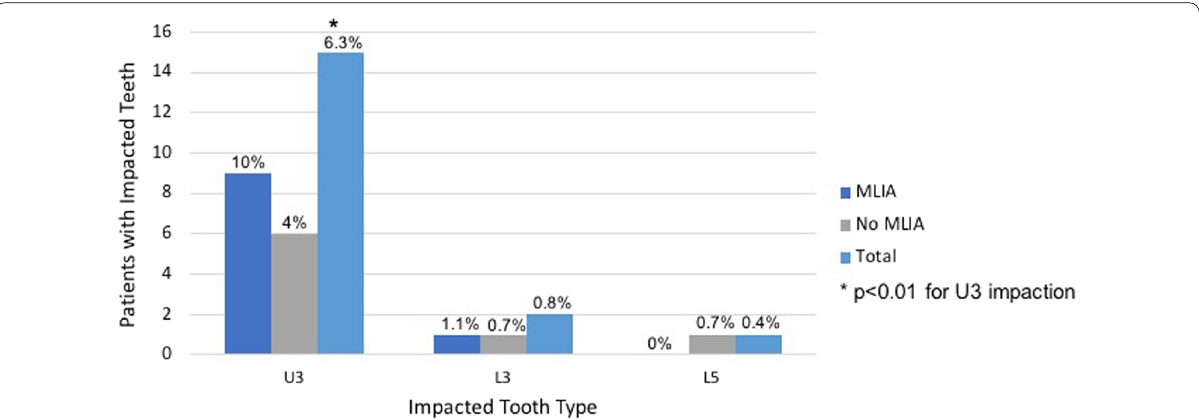
Fig. 4 Distribution of impacted teeth among the non-syndromic tooth agenesis